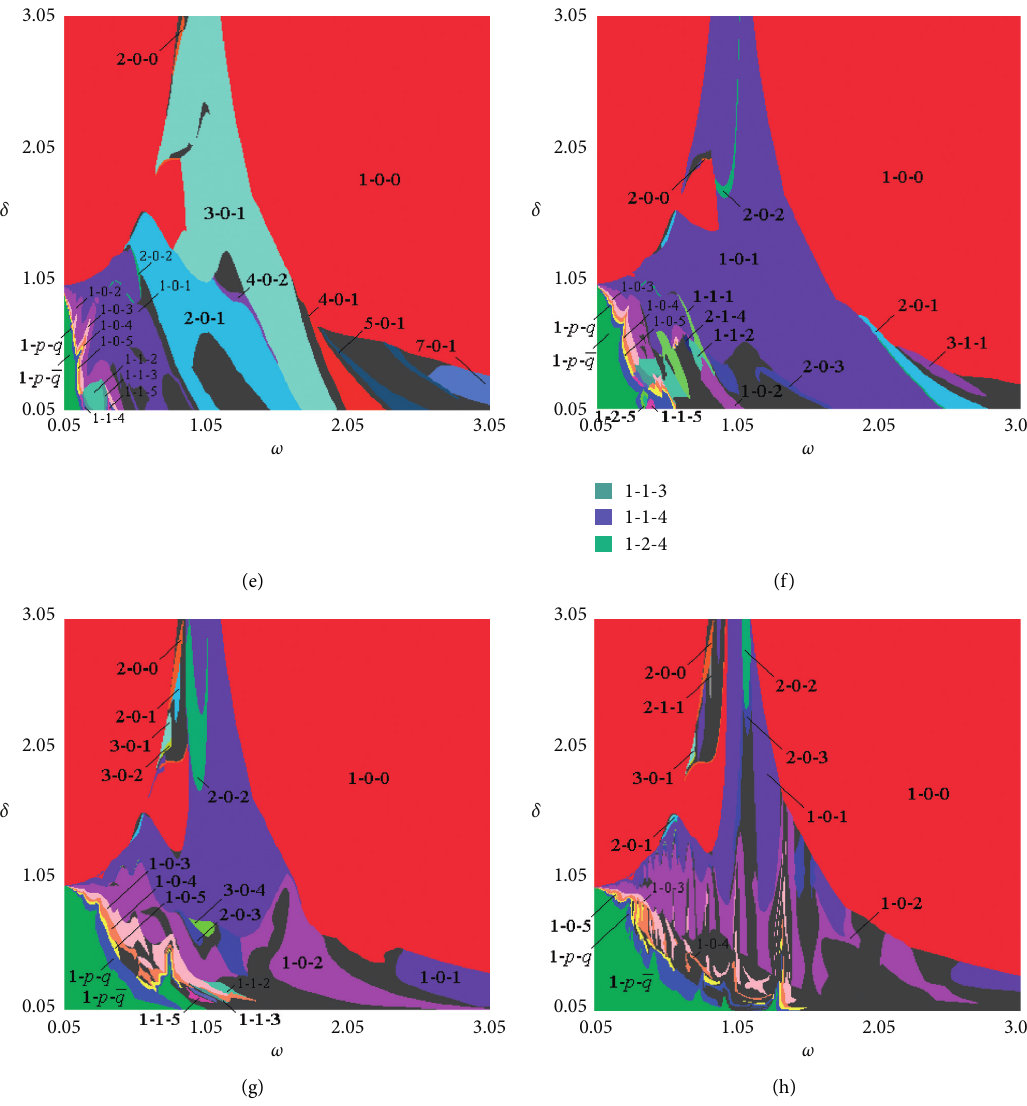
Figure 10: Under different stiffness ratios μ : μ � μ (b) M k k 0.25; (c) 1